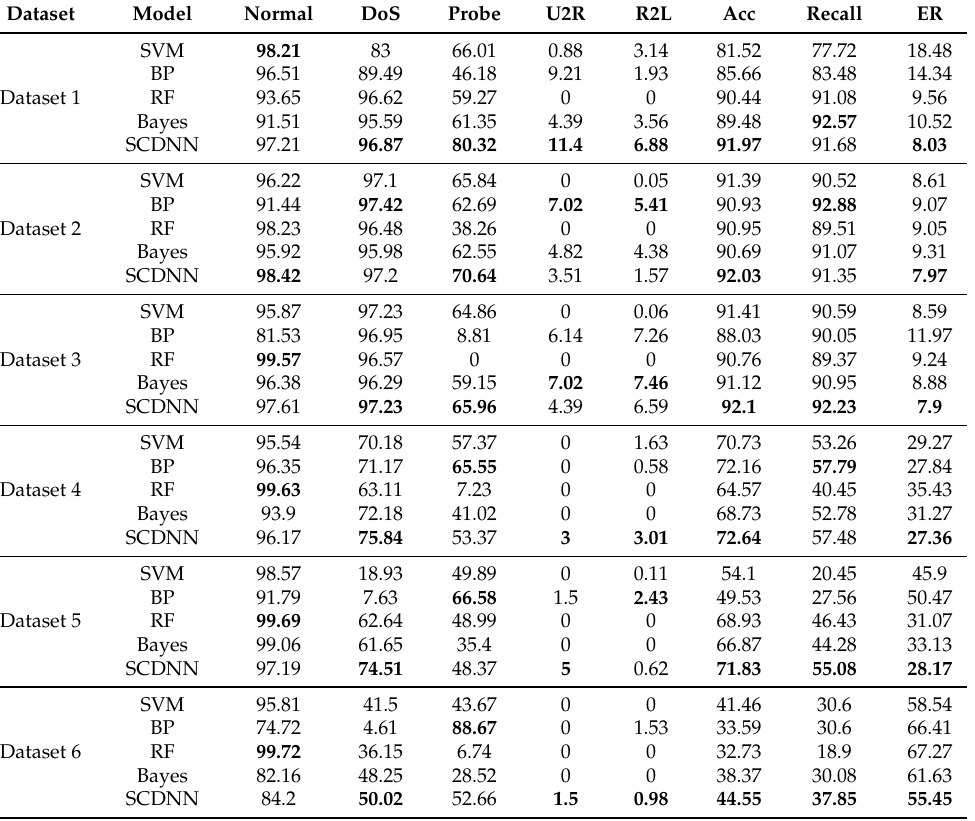
Table 3. Comparing network intrusion detection results for the six datasets